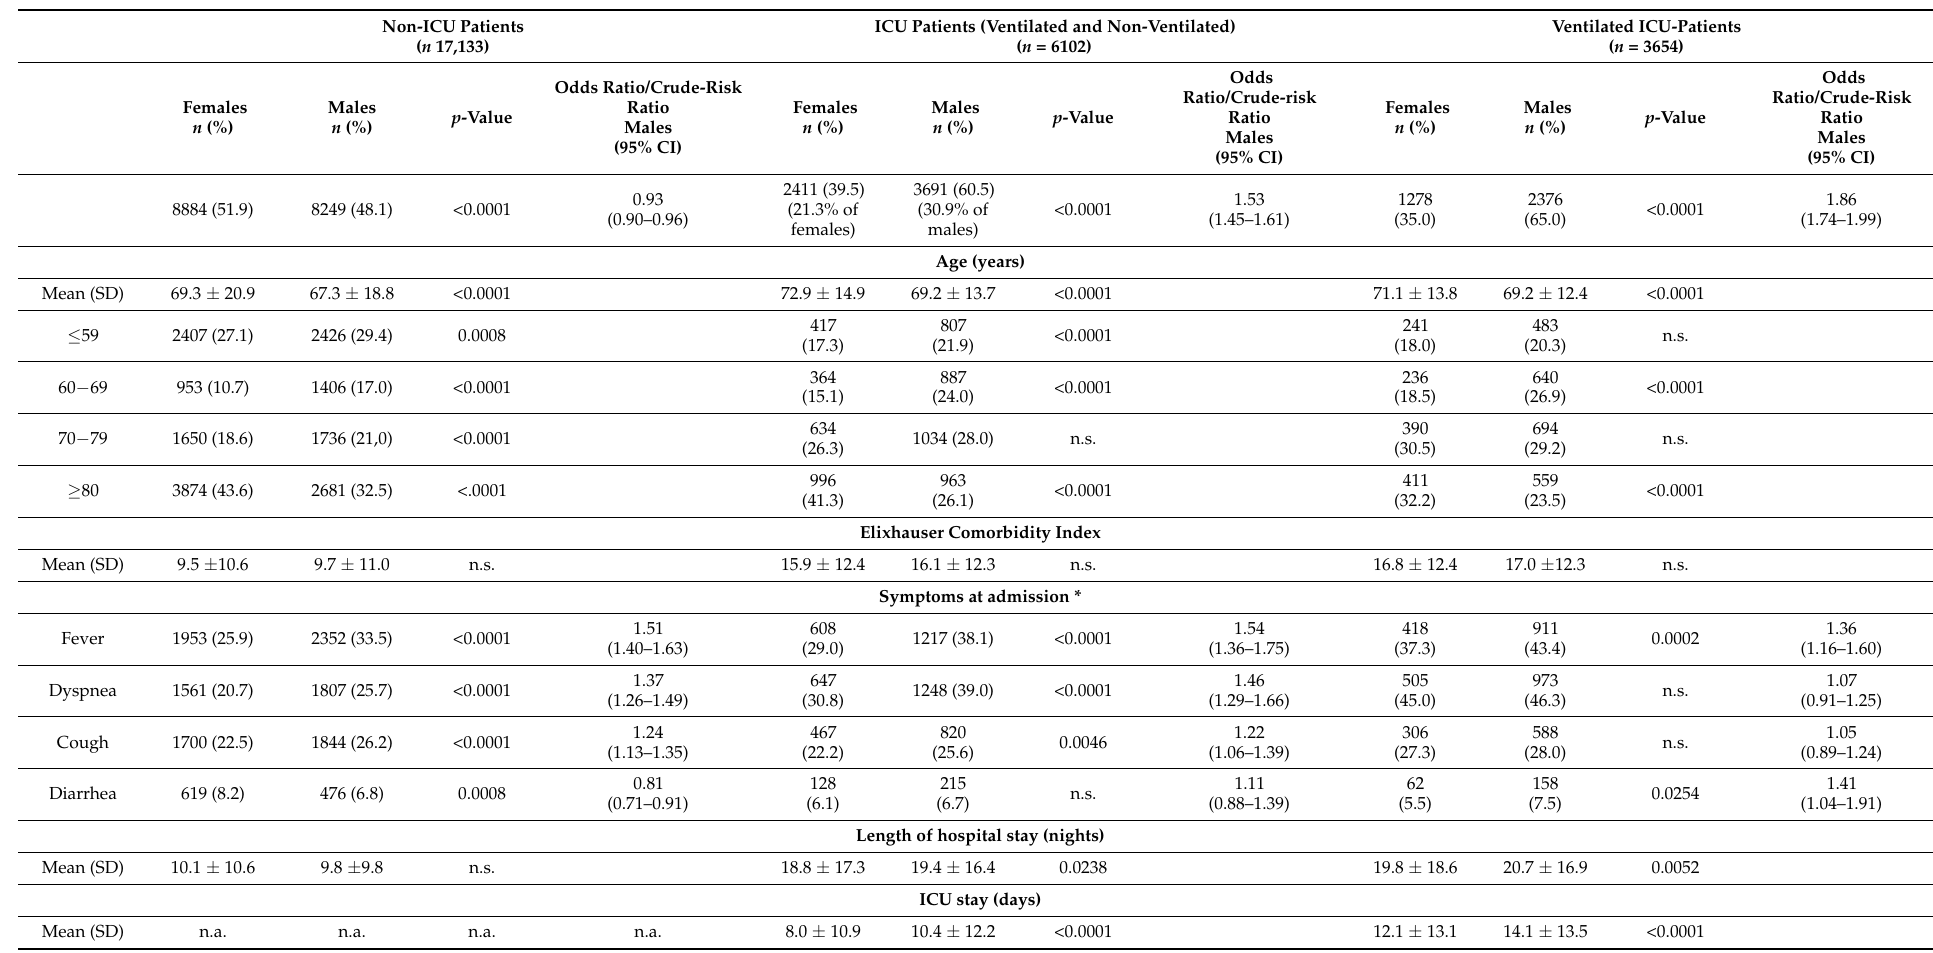
Table 2. Patient Characteristics by Sex among Non-Intensive-Care (Non-ICU), ICU Patients (Ventilated and Non-ventilated) and Ventilated ICU Patients. Non-ICU Patients ( n 17,133)